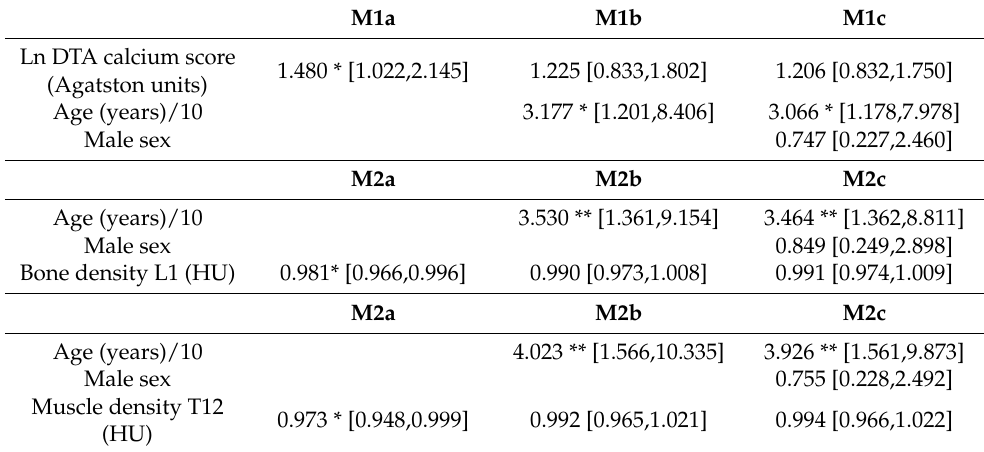
Table 3. Univariable and multivariable penalized logistic regression models used to evaluate the association between death and ln DTA calcium score, bone density, and muscle density. M1a M1b